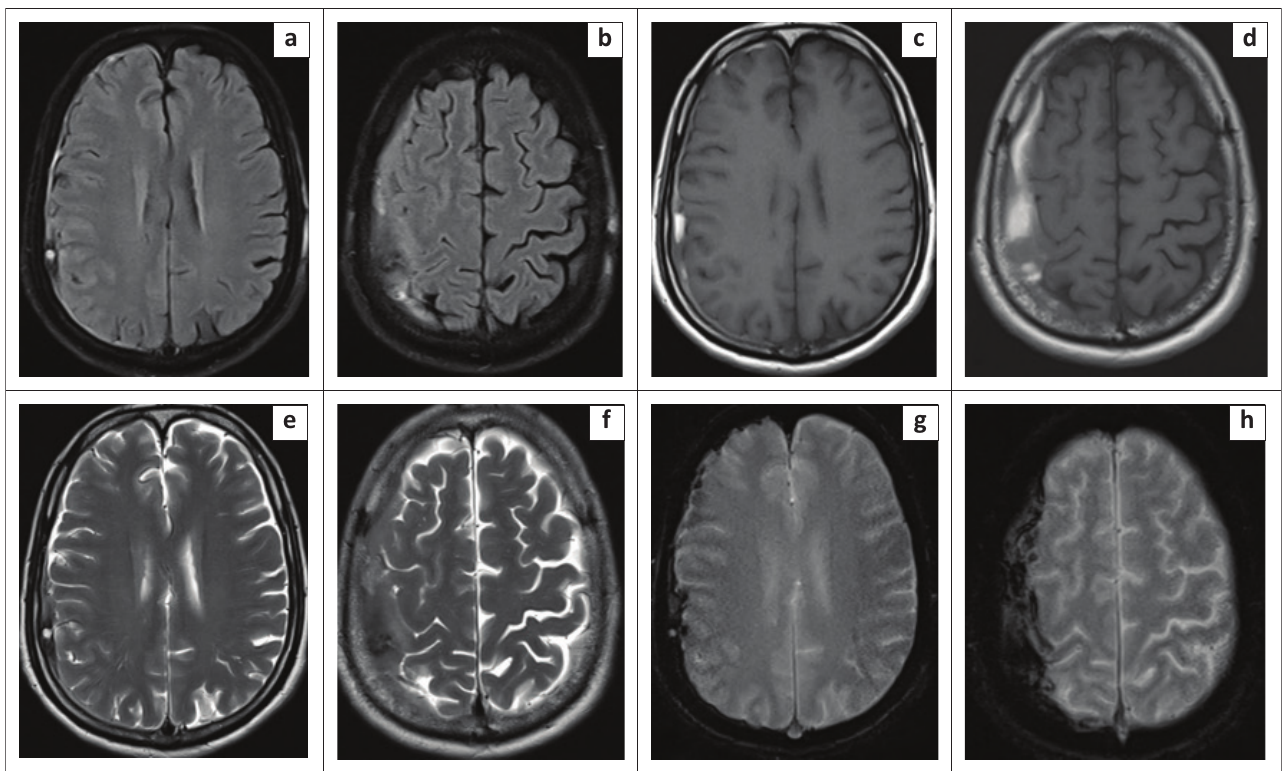
FIGURE 6: [Case 4]: Brain MRI in a 55-year-old male patient with dengue fever showing a crescent-shaped extra-axial collection overlying the right cerebral convexity, appearing hyperintense on FLAIR (a, b) and T1-weighted (c, d) images and of mixed signal intensity on T2-weighted images (e, f) with blooming on GRE images (g, h), suggestive of an acute to subacute subdural